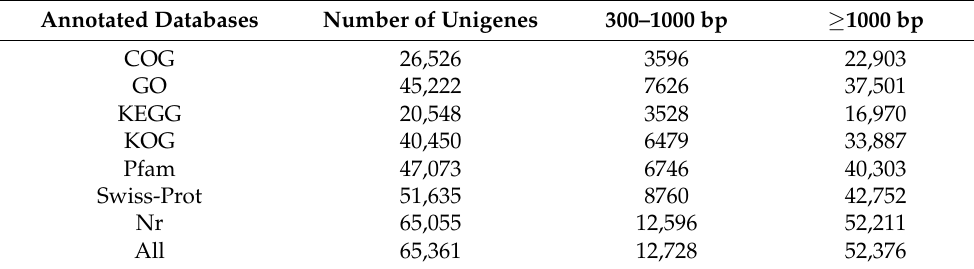
The column header 300–1000 bp indicates the number of unigenes annotated to the database whose length is ≥ 300 bases and ≤ 1000 bases. The column header ≥ 1000 bp indicates the number of unigenes annotated to the database unigene number with lengths ≥ 1000